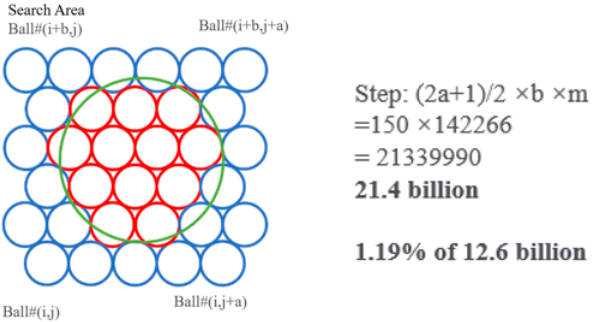
Figure 12. Illustration of the Objective Search Algorism: Clump pebble (Green Circle), Search Area (Blue Circle), Aggregate Cluster (Red Circle).